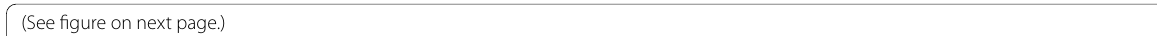
Fig. 4 Treg and cytokine analysis. A Representative dot blots showing the CD4 cell population in lymphocytes isolated from the spleen. B + Representative dot blots showing the CD25 cell population within the CD4 cells. C Representative dot blots showing the FoxP3 cell population + + in the CD4 CD25 cells. D Percentage of CD25 Foxp3 Treg in the CD4 lymphocytes isolated from the spleen. a p < 0.05 versus the C 2D‑CM + + + + + + group, b p < 0.05 versus the C 2D‑CM group, c p < 0.01 versus the C 3D‑CM group, d p < 0.05 versus the C 2D‑CM group, e p < 0.01 versus the D + + + group, f p < 0.05 versus the C group, g p < 0.01 by the C 2D‑CM group, h p < 0.01 versus the D group. E‑ Cytokine levels of the groups. a p <0.01 versus + the C group (IL‑4), b p < 0.05 versus the C group (IL‑4), c p < 0.05 versus all groups (IL‑10), d p < 0.05 versus the C group (IFNγ), e p < 0.05 versus the C 2D‑CM group (IFNγ), f p < 0.01 versus the C group (IFNγ), g p < 0.001 versus the C 2D‑CM group (IFNγ), h p < 0.05 by the C 3D‑CM group (IFNγ). + + + Data are presented as mean SEM ( n ±